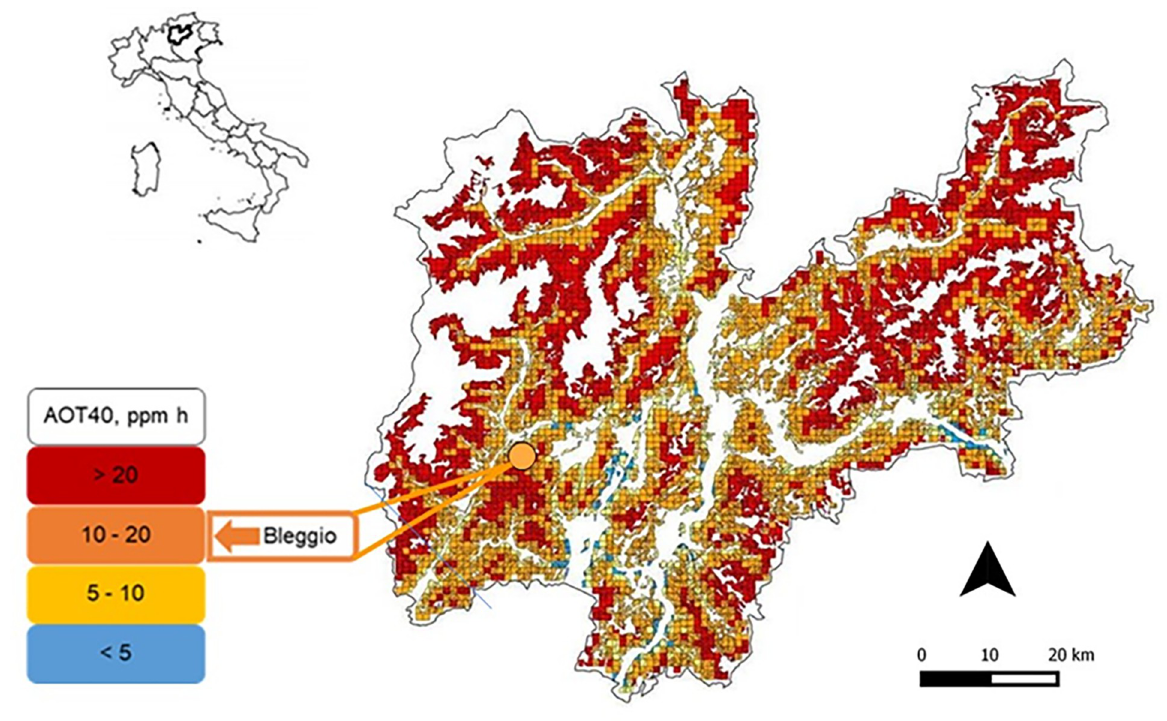
Fig 1. Study site. Location of Trento province in Italy (top left), and of the Bleggio study site within Trento province (right). Ozone was estimated for forest areas with a 1x1 km square resolution, on the basis of a modeling exercise based on a four-year measurement campaign (2007–2010) [18]. Trento province map is colored based on four AOT40 levels (see legend), and the estimate for the Bleggio site is shown on the bottom left. characteristics. Initially, 30 V . lantana plants along the light-exposed edge of vegetation were surveyed and data were collected on: i) aspect of the light exposed part of the plant (in two clas- ses: east and south, ES; west and north, WN); ii) plant shading (in three classes: 0; < 50%; > 50%); iii) plant height, as a proxy for plant age (in three classes: small < 90 cm, medium 90– 180 cm, large > 180 cm; iv) ozone-induced VFS, in terms of frequency of symptomatic leaves per plant (in classes: 0; > 0–5%; > 5–50%; > 50–100%). Second, a random selection of six symp- tomatic plants was operated, three each for the small and large plant height classes. The closest non-symptomatic plant of the same height class was selected for each symptomatic individual to allow a pairwise comparison. A random stem per each plant (n = 12) was collected, and all leaves were sampled per each stem portion (lower, medium and higher third, as a proxy for leaf age). All symptomatic leaves for each stem sector were included in the leaf trait measure- ment, and a balanced number of non-symptomatic leaves was randomly selected for the analy- sis. The field assessment on the n = 30 plants was carried out on 12 August 2020; leaf sampling and further measurements on the sub-set of n = 12 plants were carried out on 19 August 2020. Leaf traits assessment. Each leaf was measured for a series of morpho-physiological traits. A Minolta SPAD 502 chlorophyll meter (Konica, Minolta) was used to measure the leaf SPAD values as a proxy of chlorophyll content (Chl ). An RGB picture of each leaf on graph SPAD paper was analysed for Leaf Area (LA, cm 2 ) estimation by ImageJ [20]. Subsequently, the amount of ozone-induced symptoms (in classes, 0: absent; 1: 1–5%; 2: 6–50%; 3: > 50) was visually assessed as reported by Gottardini et al. [19]. Gel nail polish was used to create a leaf imprint of a fixed area on both the adaxial and abaxial surface of each leaf, at the three thirds of the lamina (six imprints per leaf; imprint area = 5.36 mm 2 ). These imprints were then